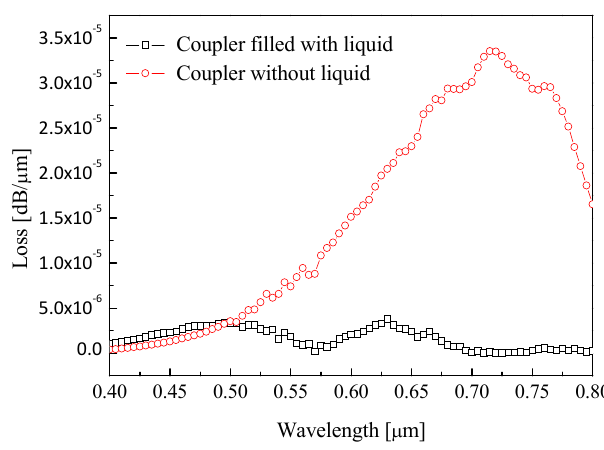
Figure 7. Confinement loss as a function of filling material.